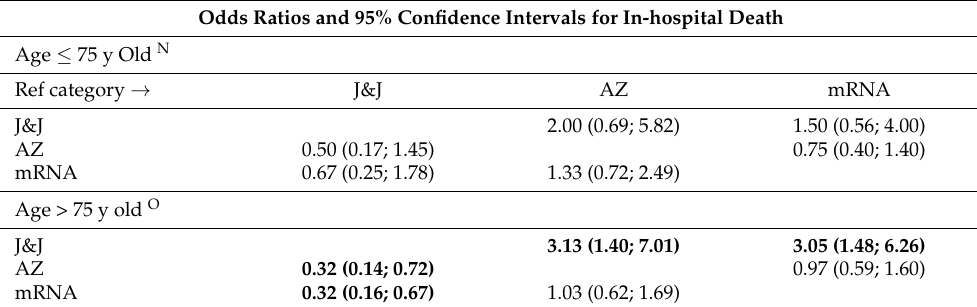
L Adjusted for age, obesity, chronic lung disease, cognitive impairment, solid organ transplantation, mean ICU occupancy rate, time since vaccination, and age x time since vaccination (interaction). M Adjusted for sex, nursing home residency, and hematological cancer. Bold numbers signal statistically significant observations ( p < 0.05). Table A5. Secondary results stratified on age for outcome in-hospital death. Odds Ratios and 95% Confidence Intervals for In-hospital Death